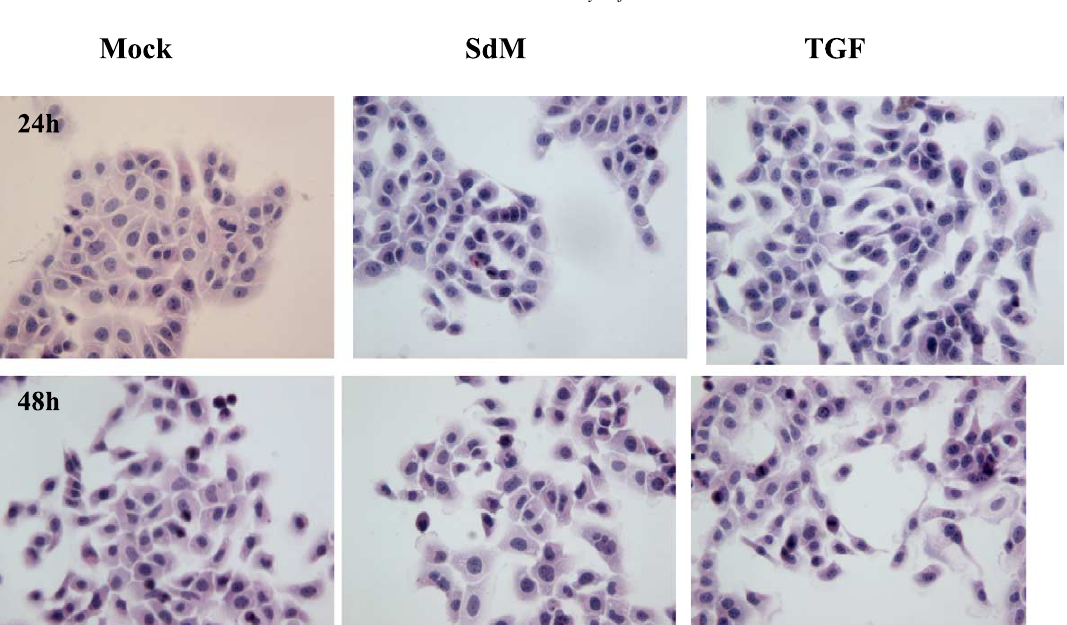
Fig. 3. TGF- β 1 treatment induced subtle changes to the spindle cell phenotype. Cells were treated with Mock, SdM or TGF for 24 h and then cultured in fresh media supplemented with FCS for another 24 h and assessed at 48 h. Cells with spindle morphology and cells with long cytoplasmic processes were more frequently observed following TGF- β 1 treatment ( × 10 objective, Leitz Laborlux K, Germany). (The colors are visible in the online version of the article.)